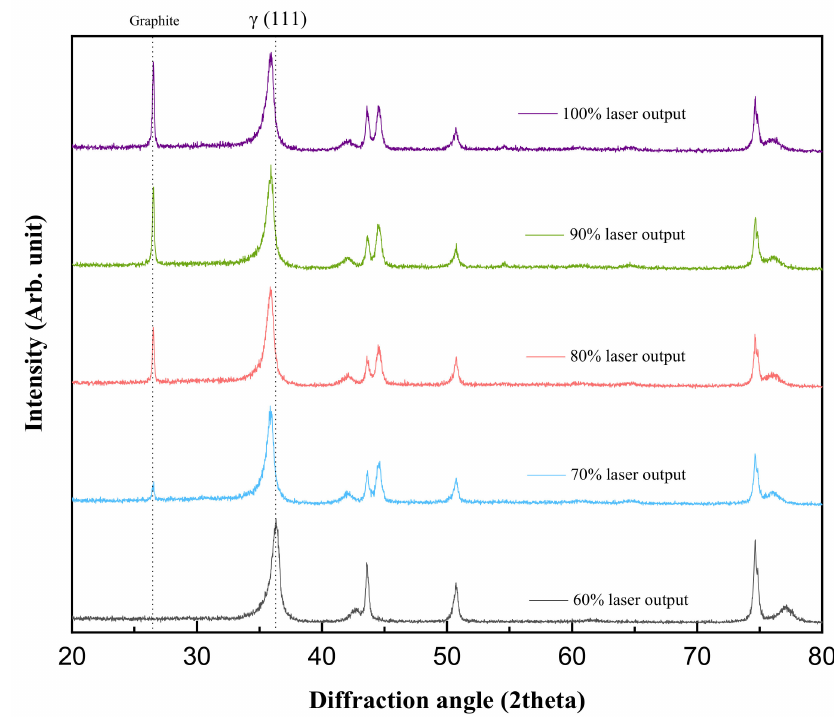
Figure 2. XRD patterns of carbon-doped SUS304 peaks by laser